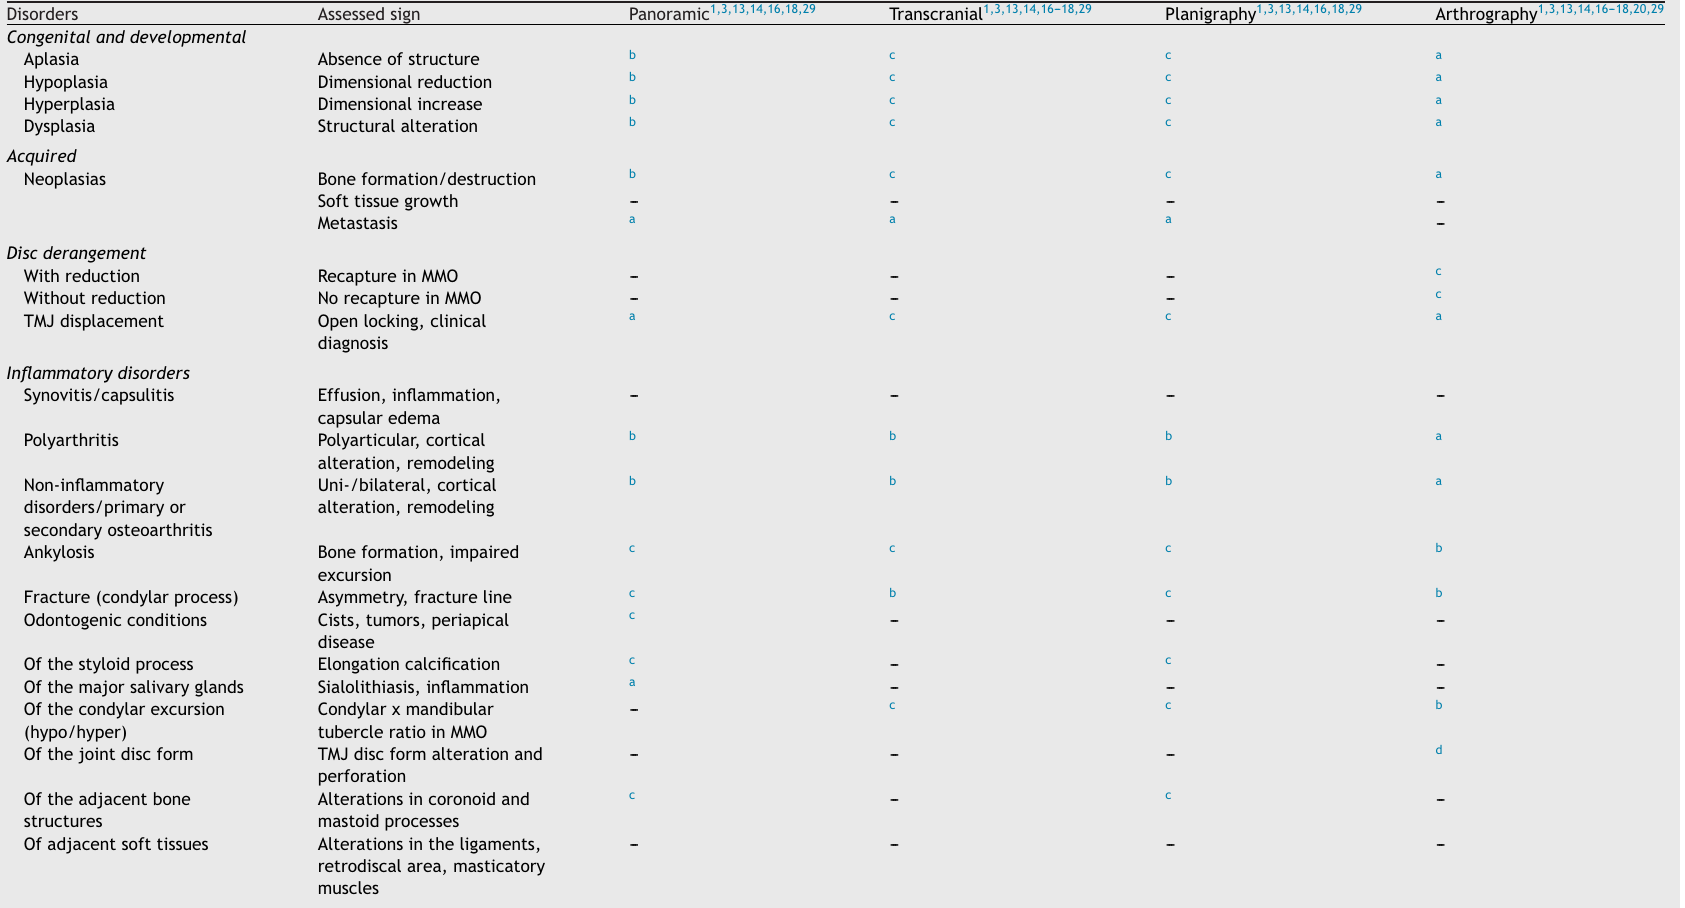
Indication of imaging tests to diagnose joint TMD and alterations in structures adjacent to the stomatognathic